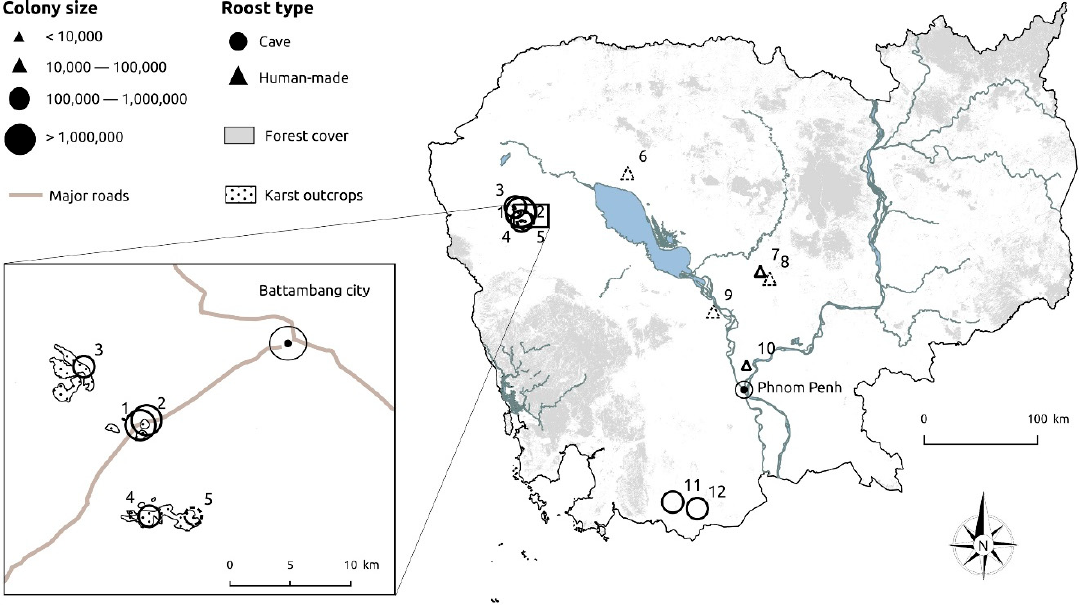
Figure 1. Location of study sites (No. 1 and 4), and other major Chaerephon plicatus colonies in Cambodia. Symbols with solid lines represent permanent roosts whereas symbols with dashed lines represent seasonal roosts.